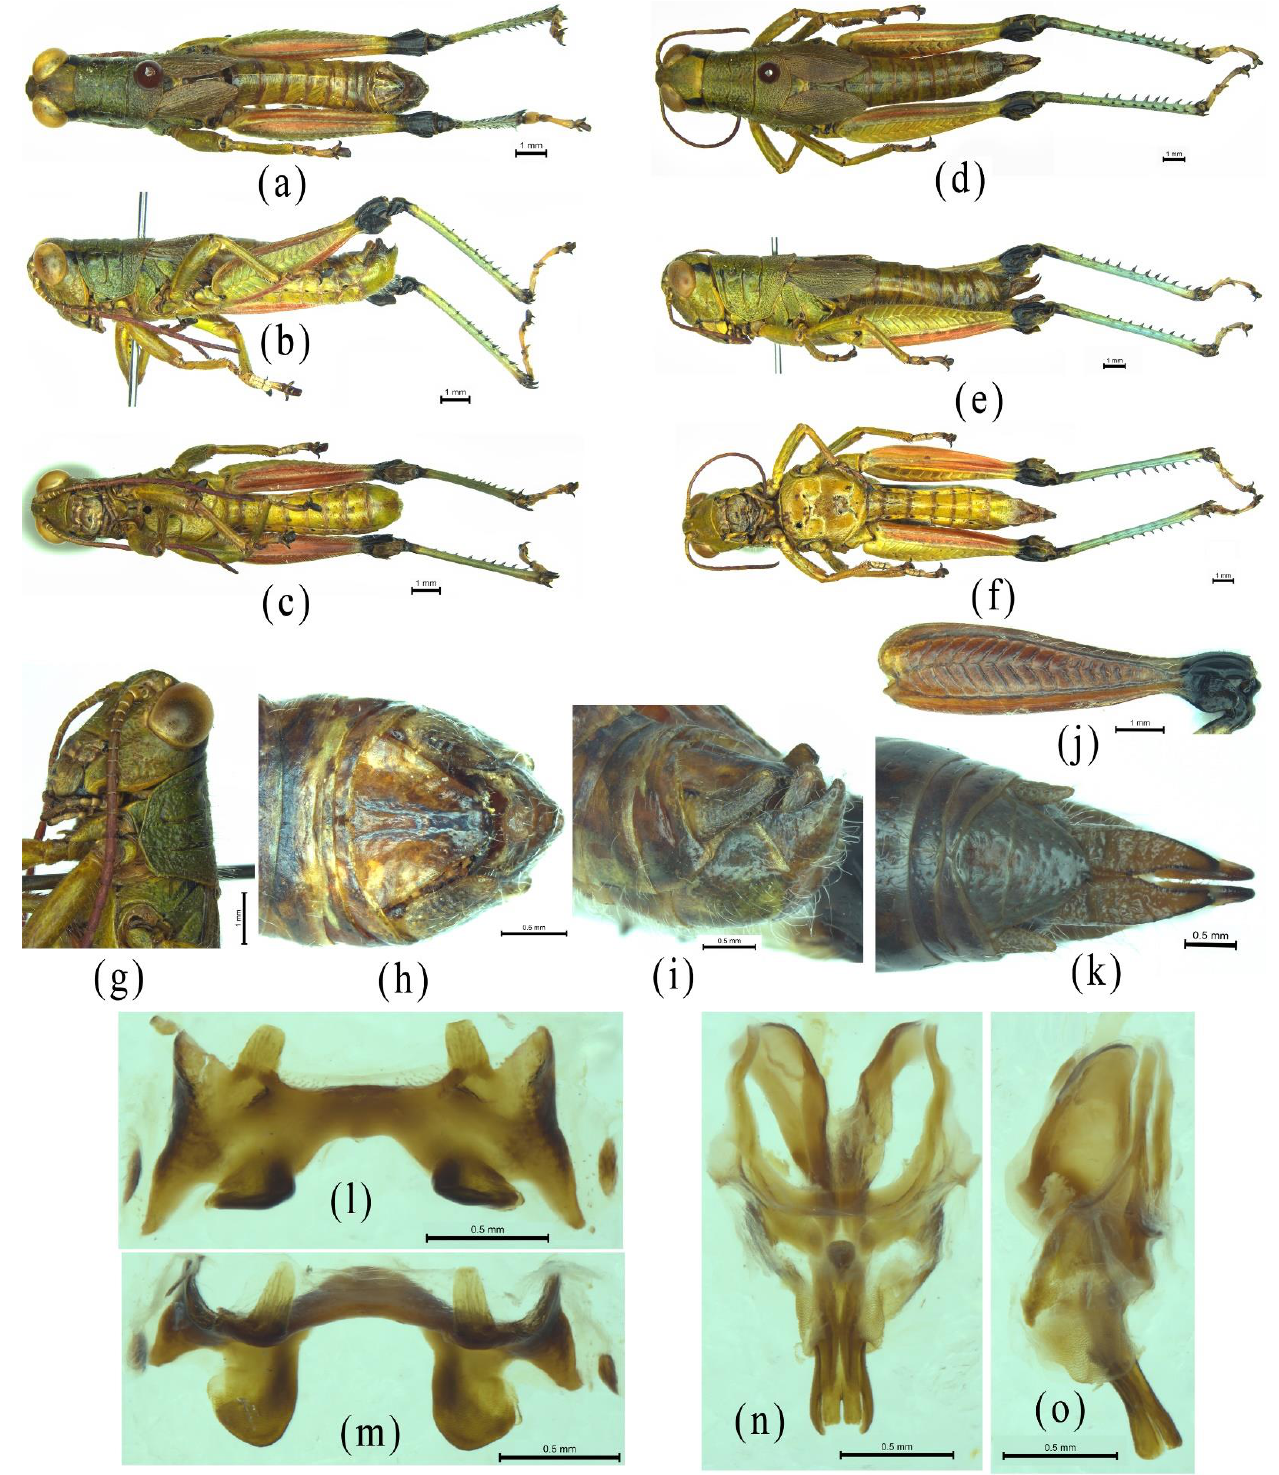
Figure 5. Morphological characters of Alulacris shilinensis . ( a – c ) Male habitus. ( d – f ) Female habitus. ( g ) Head and pronotum of male showing the shape of the prosternal process. ( h ) Terminal abdomen of a male in dorsal view showing the furculum. ( i ) Terminal abdomen of a male in lateral view showing the shape of cercus. ( j ) Hind femur of a male in lateral view showing the absence of denticles at the upper median keels. ( k ) Terminal abdomen of a female in dorsal view. ( l , m ) Epiphallus in dorsal and anterodorsal view. ( n , o ) Phallic complex in dorsal and lateral view.